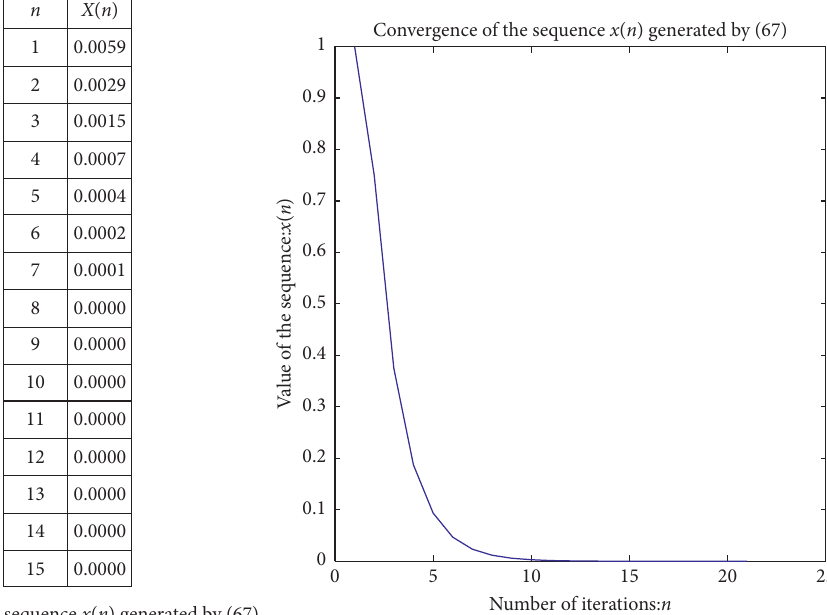
􏼈 􏼉 generated by (67) versus number of iterations n : � 0 , 1 , . .. , 15 { } with an initial choice of n